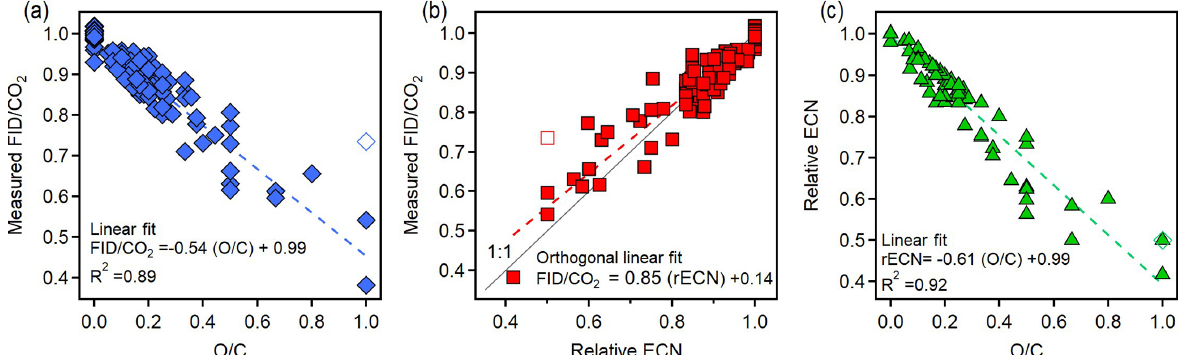
Figure 4. Plots relating the three variables: measured FID / CO 2 relative to n -alkanes, relative ECN, and O / C. Comparisons shown are (a) FID / CO 2 versus O / C, (b) FID / CO 2 versus relative ECN, and (c) relative ECN versus O / C. Dashed lines are linear fits; fits assume error only in dependent variables in the case of comparisons to O / C (which has no error) and assume error in both variables (“orthogonal fit”) in the case of the rECN comparison to FID / CO 2 . Methanol is shown in each plot as an unfilled marker as there are physical reasons it may be an outlier (discussed in the main text). The respective percentage error of the slope and intercept for each relationship is (a) 4%, 1%; (b) 4%, 22%; and (c) 3%, 1%.